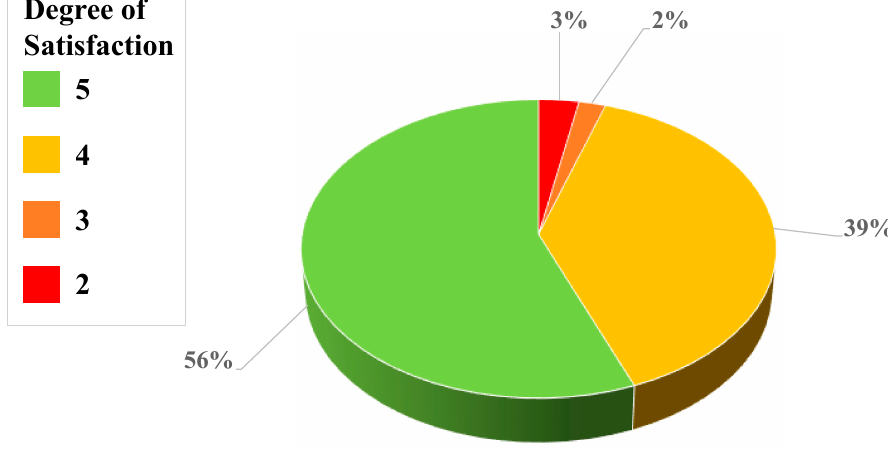
Figure 5. Distribution of satisfaction scores from the questionnaire by professional radiologists. The questionnaire is designed to collect feedback from the professionals regarding the experience when testing the automatic report generation system. The colors indicate different degrees of satisfaction, where green is used for higher scores (more satisfied) in the questionnaire, and red indicates the lower scores (less satisfied).